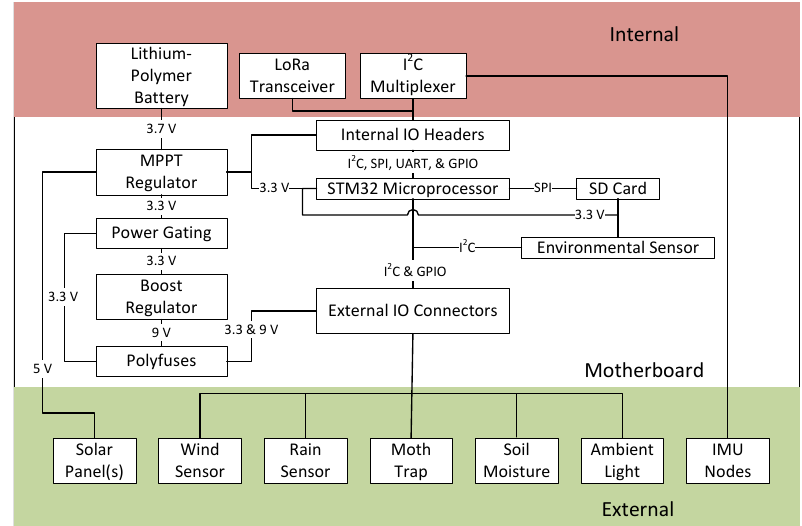
Figure 3. A block diagram of the main system components and their